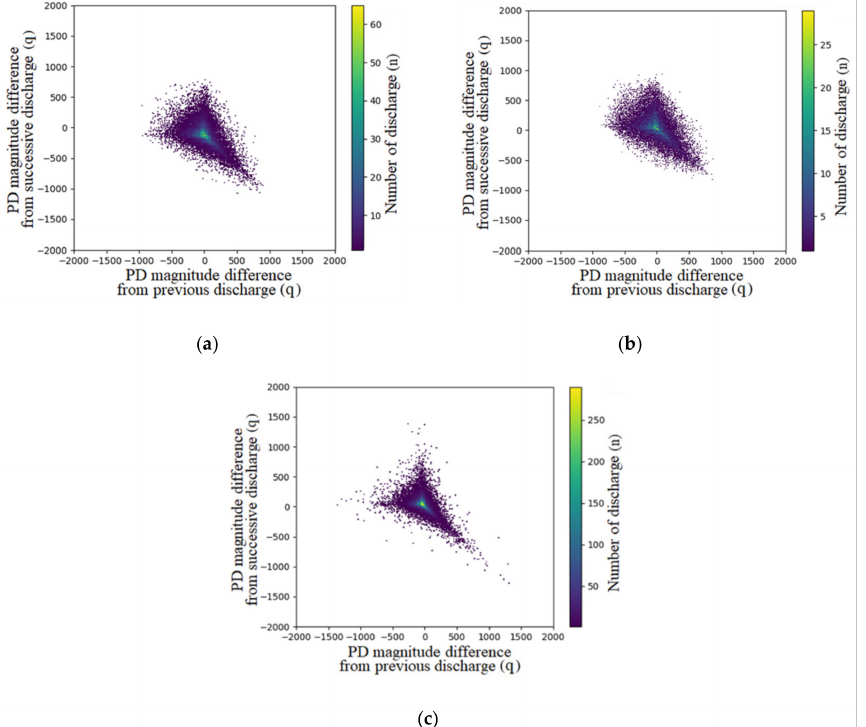
Figure 11. DC void discharge patterns in the discharge colony classified as void discharge through TF mapping: ( a ) initial discharge occurrence; ( b ) beginning of insulation aging; ( c ) period before the dielectric